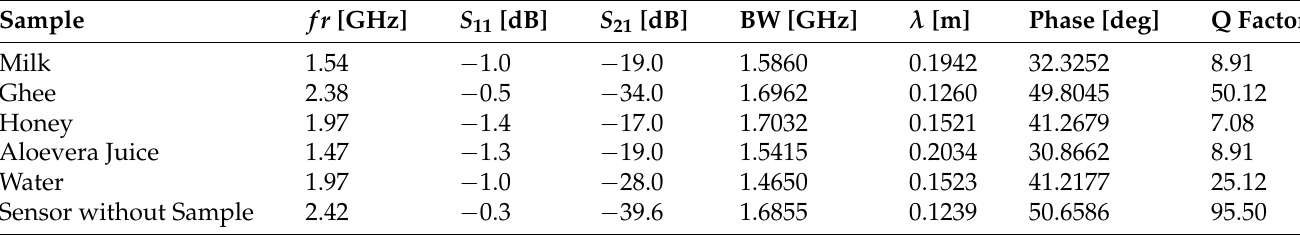
Figure 25. Senor testing in liquid samples: ( a ) variation in scattering parameters with frequency; ( b ) variation in transmission coefficient parameters with frequency. Table 8. Liquid sample